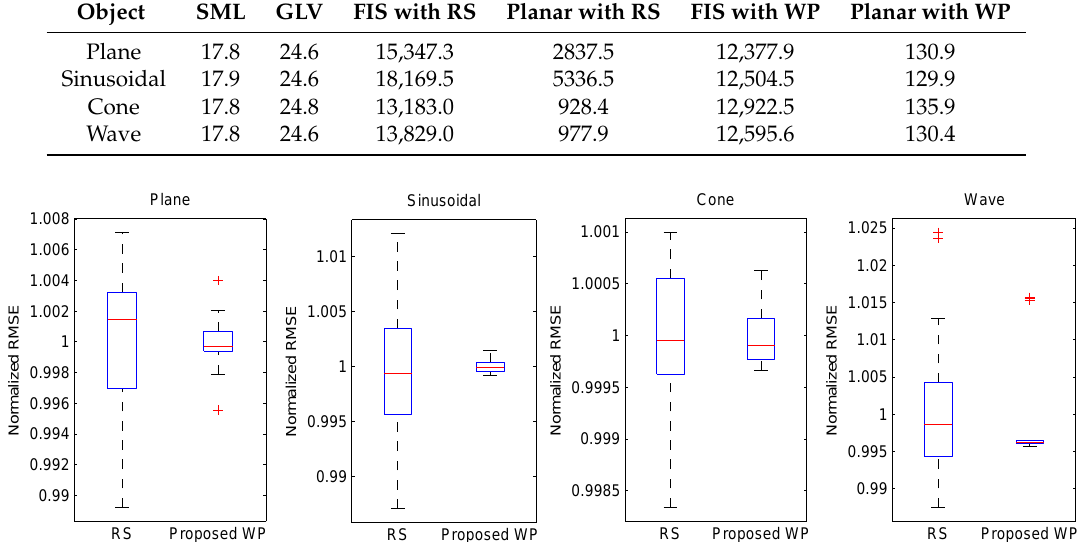
Figure 7. Box plot of the normalized Root-Mean-Square-Error (RMSE) from 30 experiments for Planar with WP and Planar with RS using various